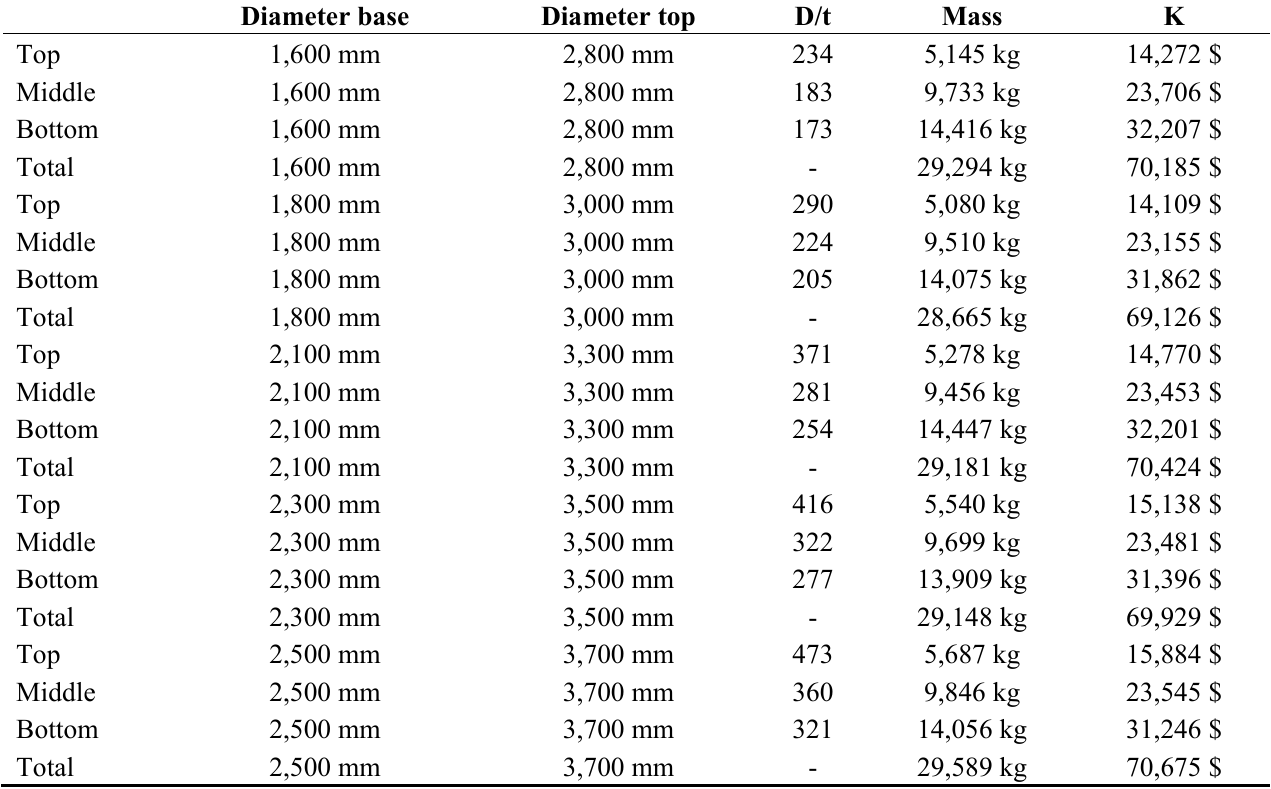
Table 10. Optimization results depending on the same taper